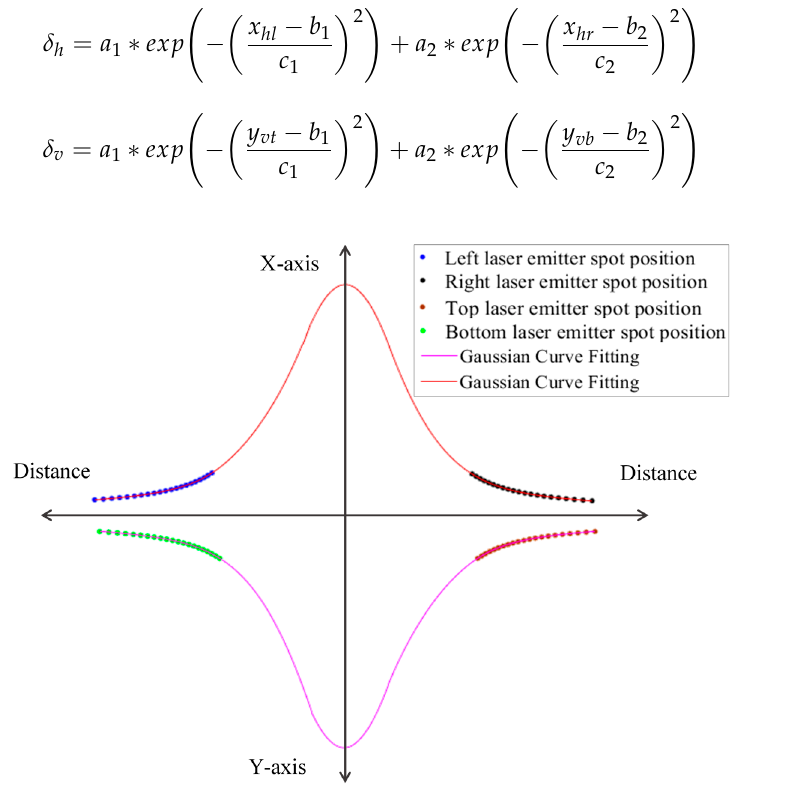
Figure 6. Sketch of fitting laser spots coordinates with the correspondent distance using linear regression curve fitting based on Gaussian distribution model.